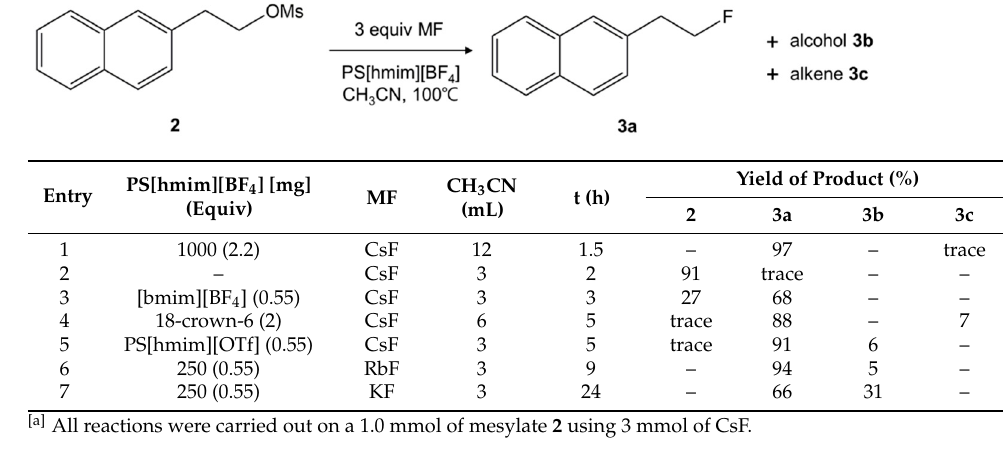
Table 4. Fluorinations of mesylate 2 with alkali–metal fluorides (MF) using PS[hmim][BF 4 ] or the stated alternative reagents [a] .